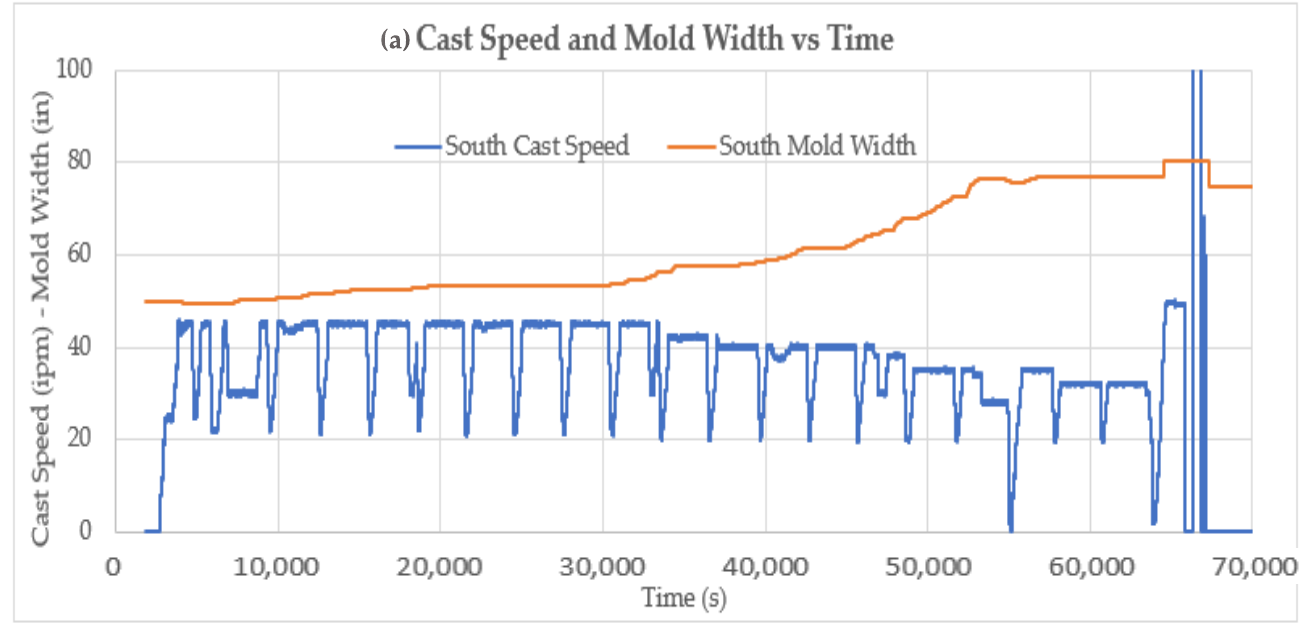
Figure 18. Net strain at all roll locations superimposed on casting speed and slab width data for a 20-heat cast sequence over approximately 14 h of caster operation.